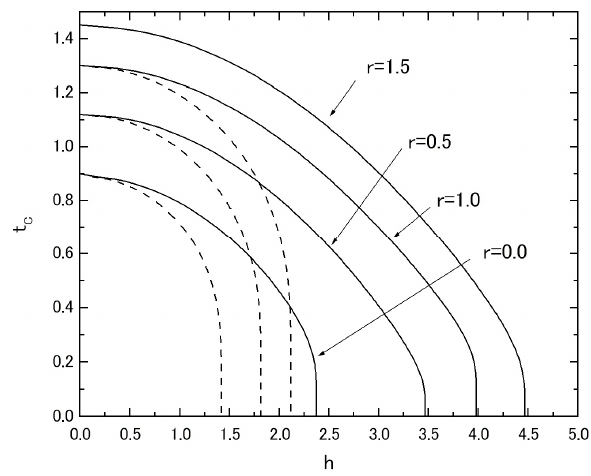
Figure 2. The phase diagram ( t C versus h plot) for the system A, when the value of r is changed from r = 0.0 to r = 1.5.